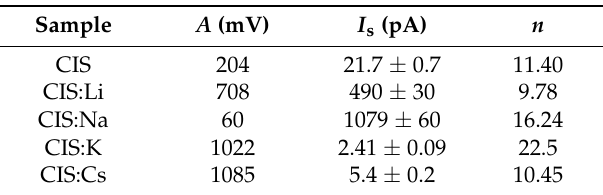
Table 1. Fitting parameters.